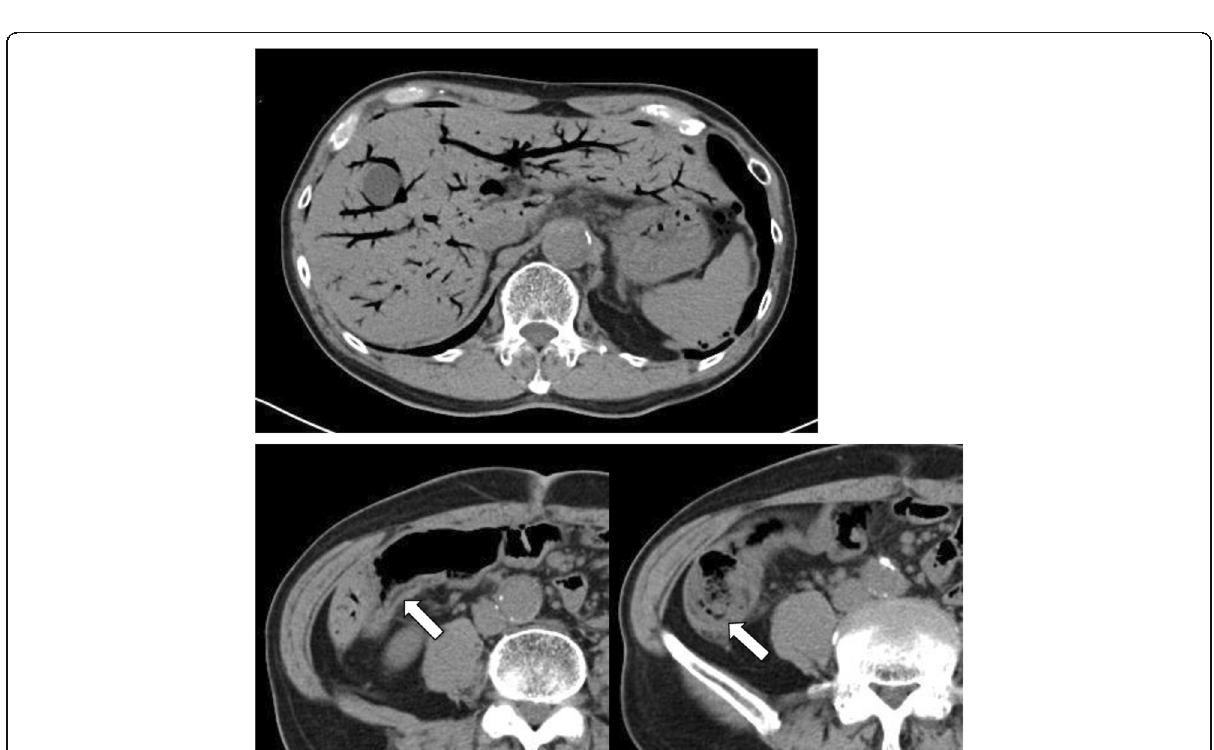
Fig. 2 CT 6 days after the operation. CT showed portal venous gas over the entire area of the liver. The arrow shows pneumatosis intestinalis in the thick wall of the ascending